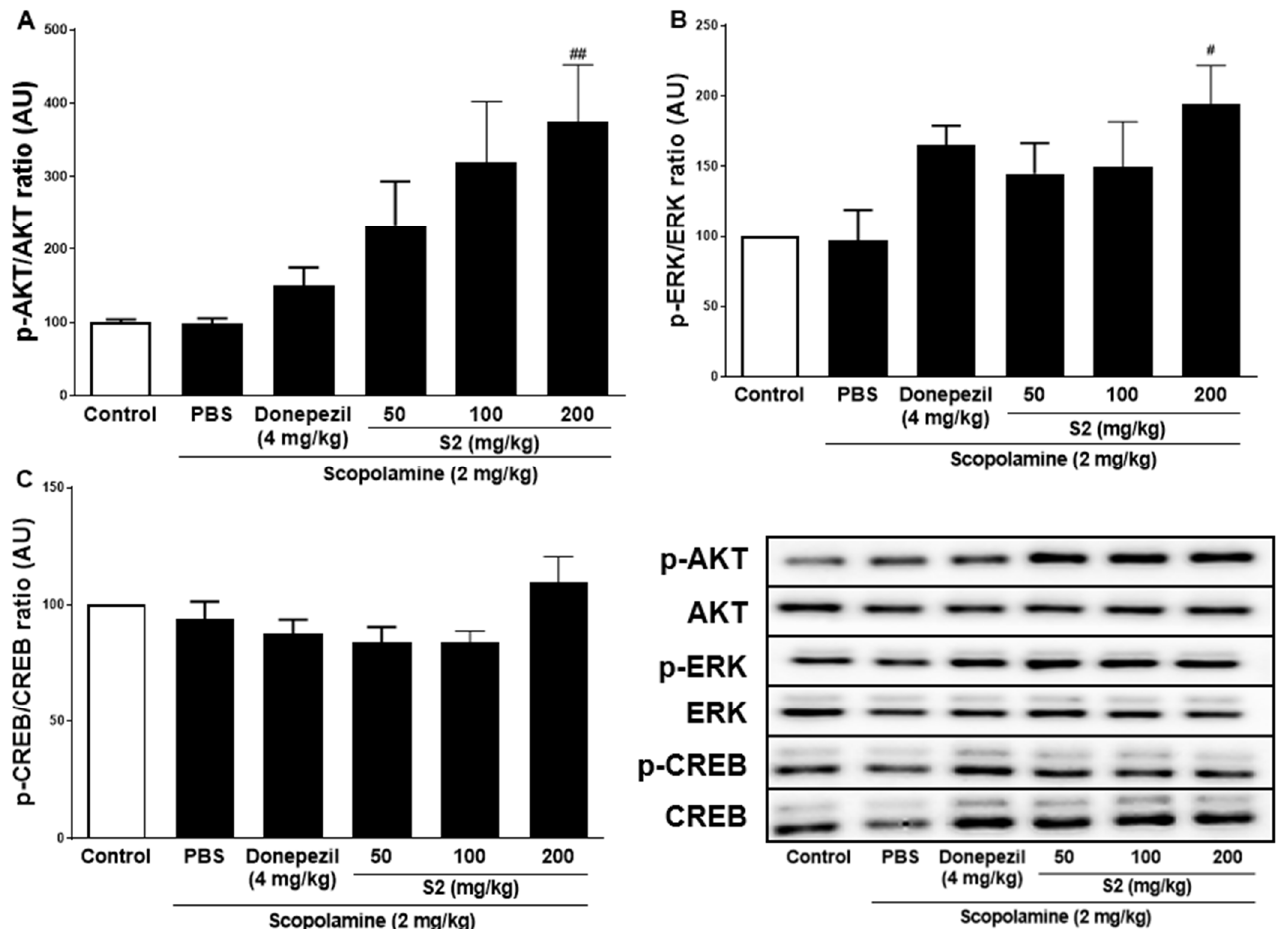
Figure 5. S2 extract suppressed memory related p-CREB/AKT/ERK signal pathway in scopolamine-induced mouse cortex. The expression of ( A ) p-AKT, ( B ) p-ERK, and ( C ) p-CREB were measured by western blot. Data are detected as mean ± SEM. Compared with Scopolamine group, #: p < 0.05, ##: p < 0.01 (one-way ANOVA followed by Dunnett’s multiple comparisons).